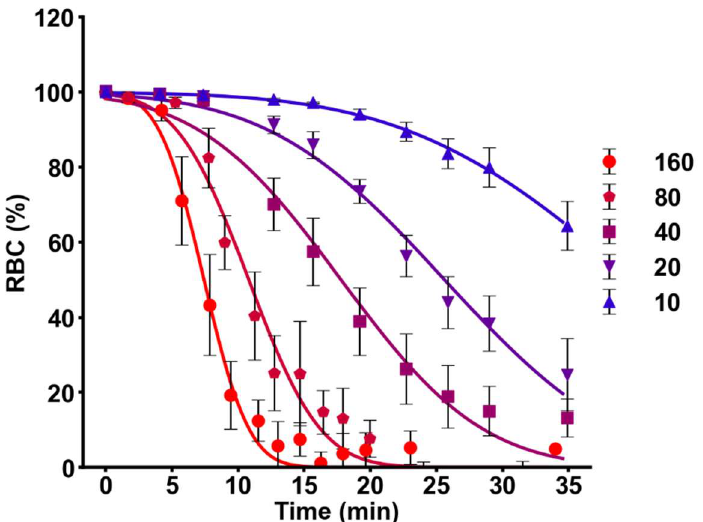
Figure 9. Fitting of time-dependent effect of HlyA on hemolysis. RBCs suspensions at 5% hematocrit were treated for different times with 5 HlyA concentrations (10–160 ng/mL). Data are expressed as the proportion of viable cells (RBC%) vs. time. The continuous lines show the fit of model 2 to experimental data at each HlyA concentration. Best fit values of the parameters are shown in Supplementary Table S1. Data represents means ± S.E.M. (N = 3–6).